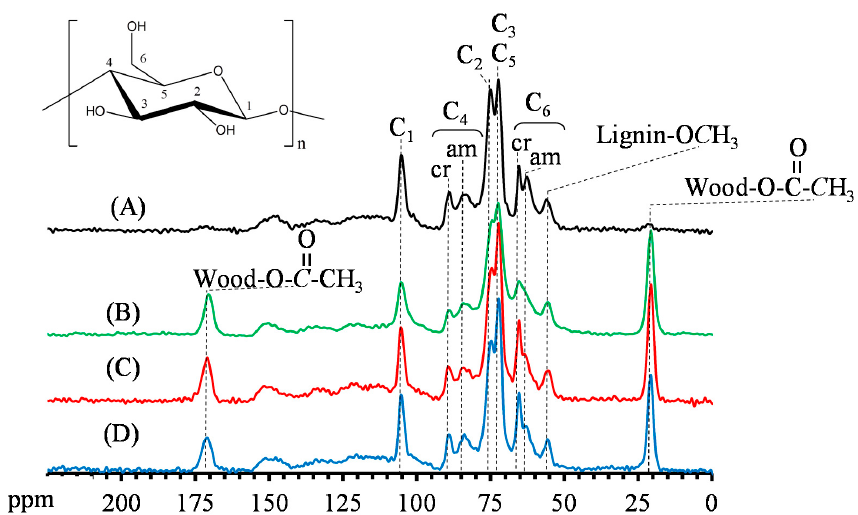
Figure 4. Solid state carbon-13 nuclear magnetic resonance ( 13 C-NMR) spectra of unmodified slicewood ( A ), AA-acetylated slicewood (WPG 21%) ( B ), and VA-acetylated slicewood (cWPG 18%) with PC ( C ) and PA ( D ).